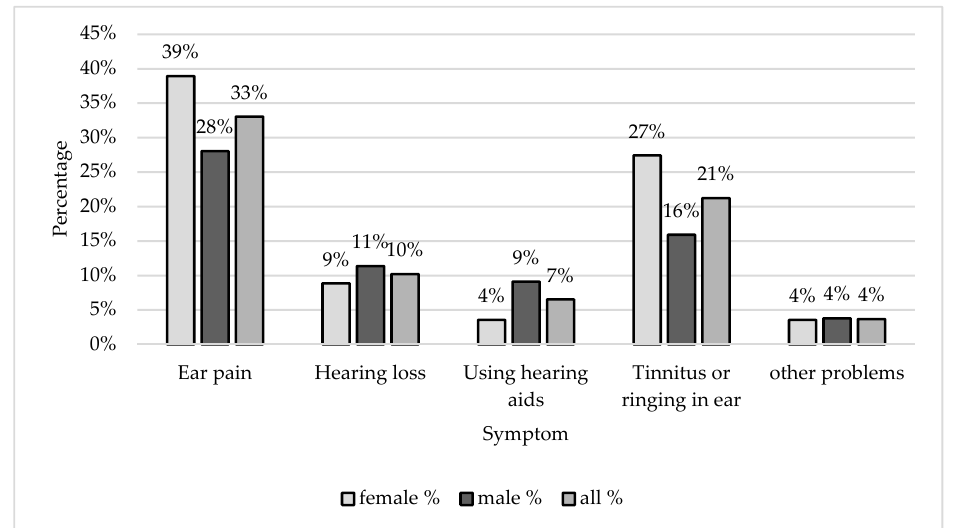
Figure 1. The frequency of different hearing symptoms experienced by the male and female participants. The percentages are calculated in reference to the whole sample size.